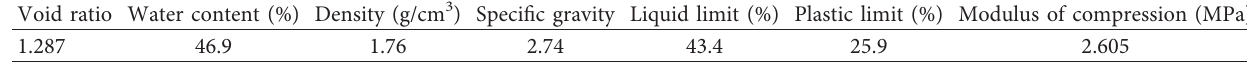
Table 1: Basic physical properties of coastal soft clay in Tianjin.